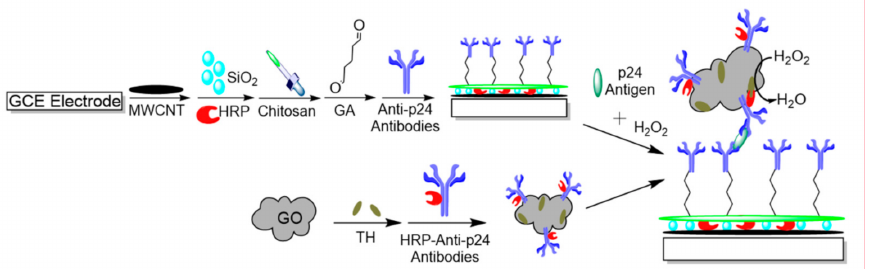
Figure 3. Schematic procedure of glassy carbon electrode (GCE) modification to detect p24 anti- gen. GCE modified with MWCNT/SiO2/HRP matrix, followed by the addition of chitosan and glutaraldehyde (GA) for attachment of anti-p24 antibodies. Graphene oxide (GO) modified with HRP-anti-p24 antibodies and thionine (TH) are added along with human immunodeficiency virus (HIV) p24 antigen and hydrogen peroxide for the detection of TH oxidized products. Adapted from Fang et al. [87] with permission from